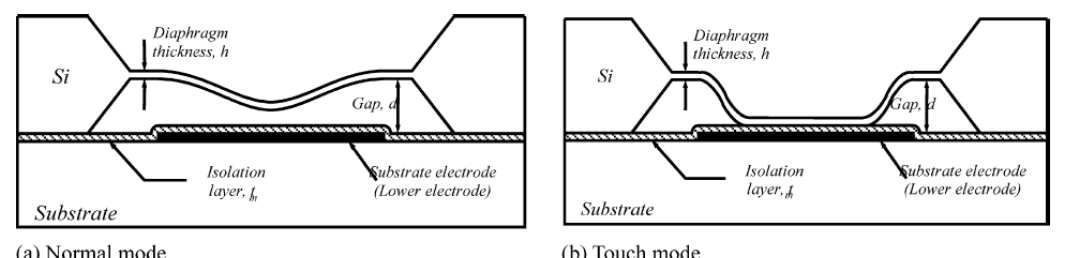
Figure 1. Structure of a touch-mode capacitive pressure sensor: (a) normal mode, (b) touch mode. The diagram is from Oh et al . [25] and is reprinted with permission from